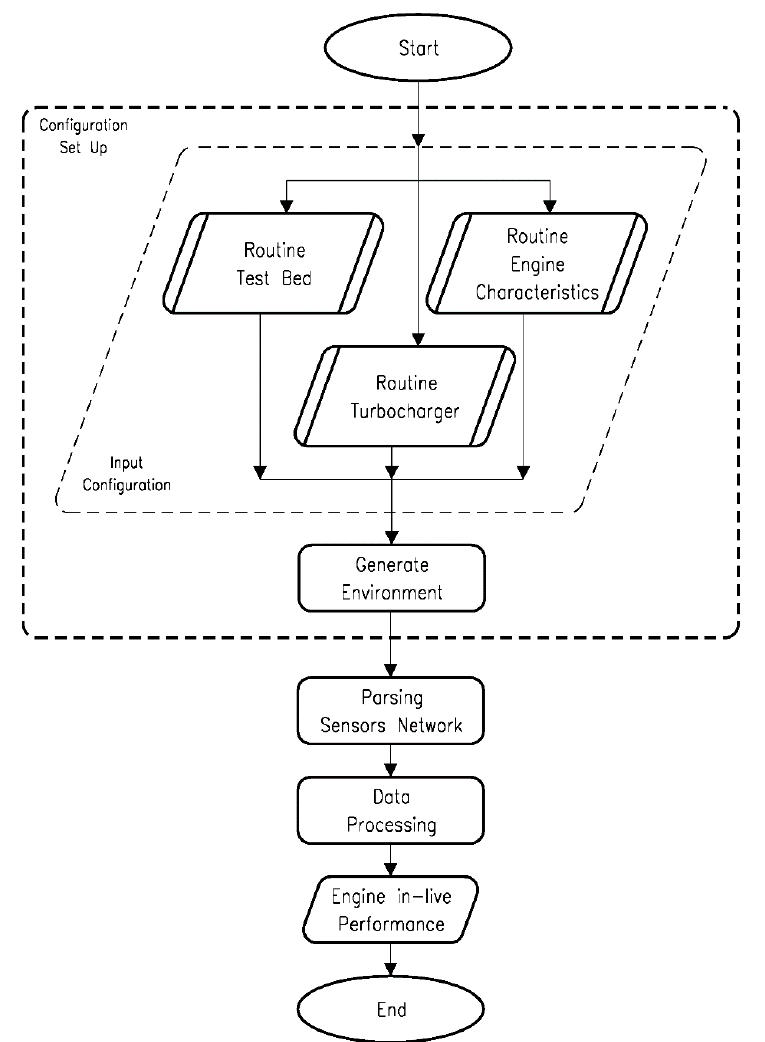
Figure 1. Main block diagram of the software.